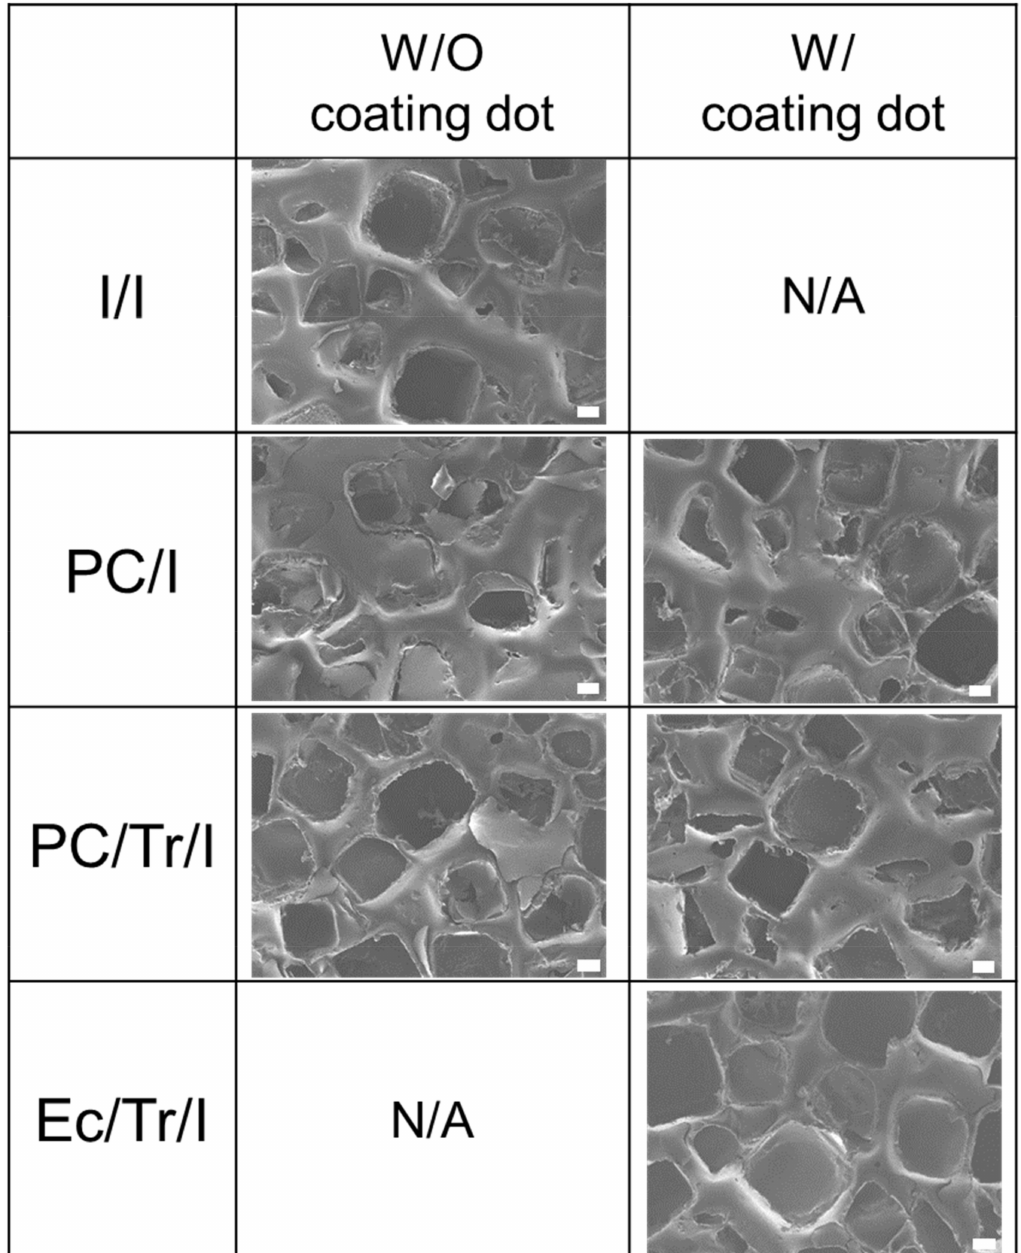
Figure 2. SEM images of the implant surfaces with coating dots (i.e., W/coating dot) and without the coating dots (i.e., W/O coating dot). Scale bars are 100 µ